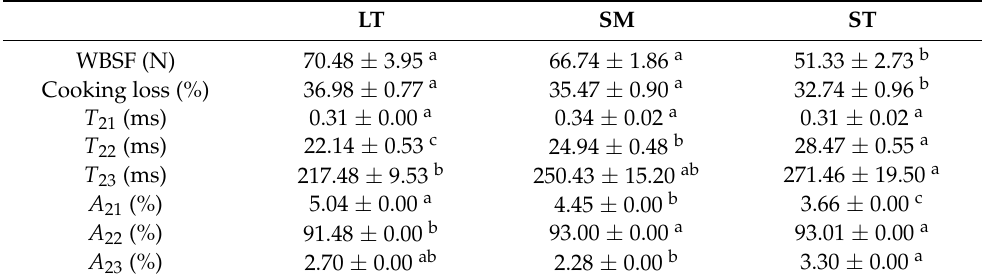
Table 1. WBSF and water holding capacity (means ± SE, n = 11) of porcine longissimus thoracis , semimembranosus and semitendinosus .